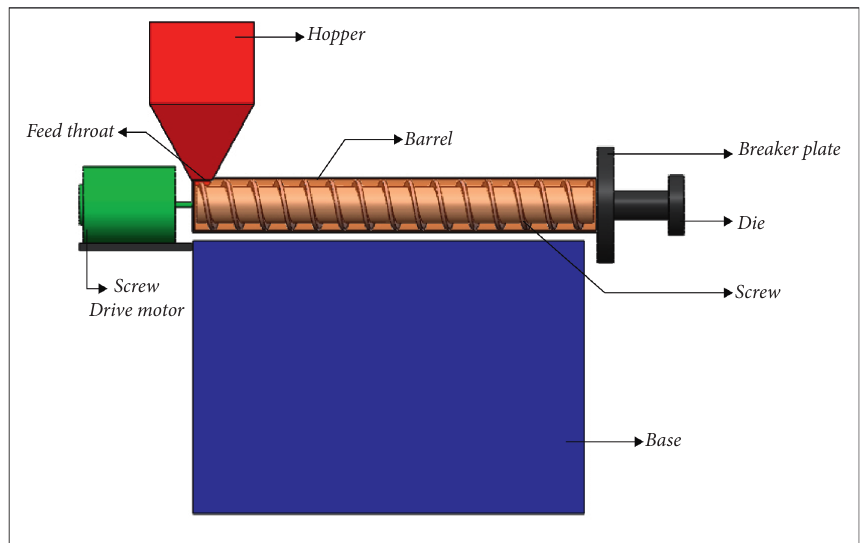
Figure 4: Double screw extrusion process arrangement.